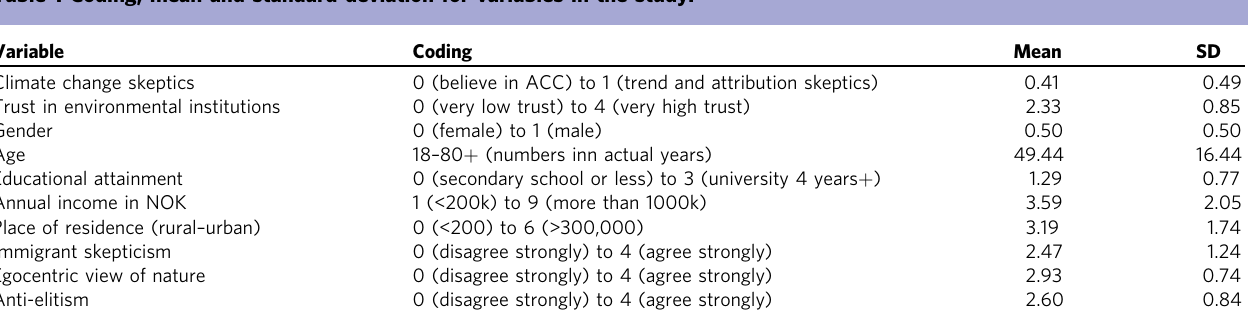
Table 1 Coding, mean and standard deviation for variables in the study. Variable